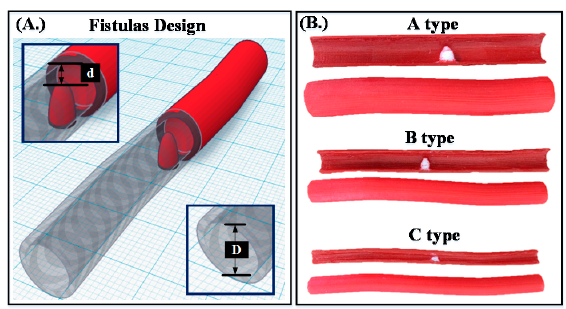
Figure 8. ( A ) Fistula design by Tinker Cad (Autodesk, Inc.). ( B ) Three types of fistula phantom designs.